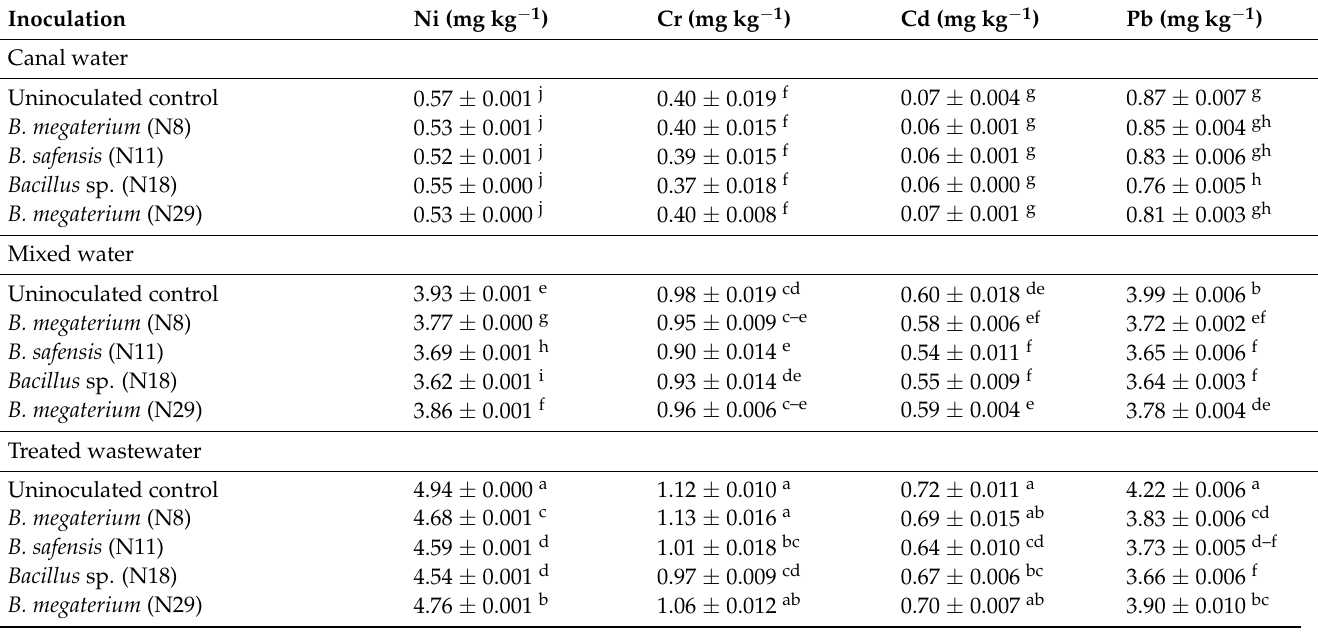
Table 6. Effect of Pb-tolerant Bacillus strains on heavy metal contents of spinach root under wastewater conditions in pot trial ( n =